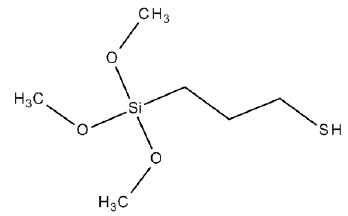
Figure 3. Silane-coupling agent MPTES (mercapto-propyl-triethoxysilane).